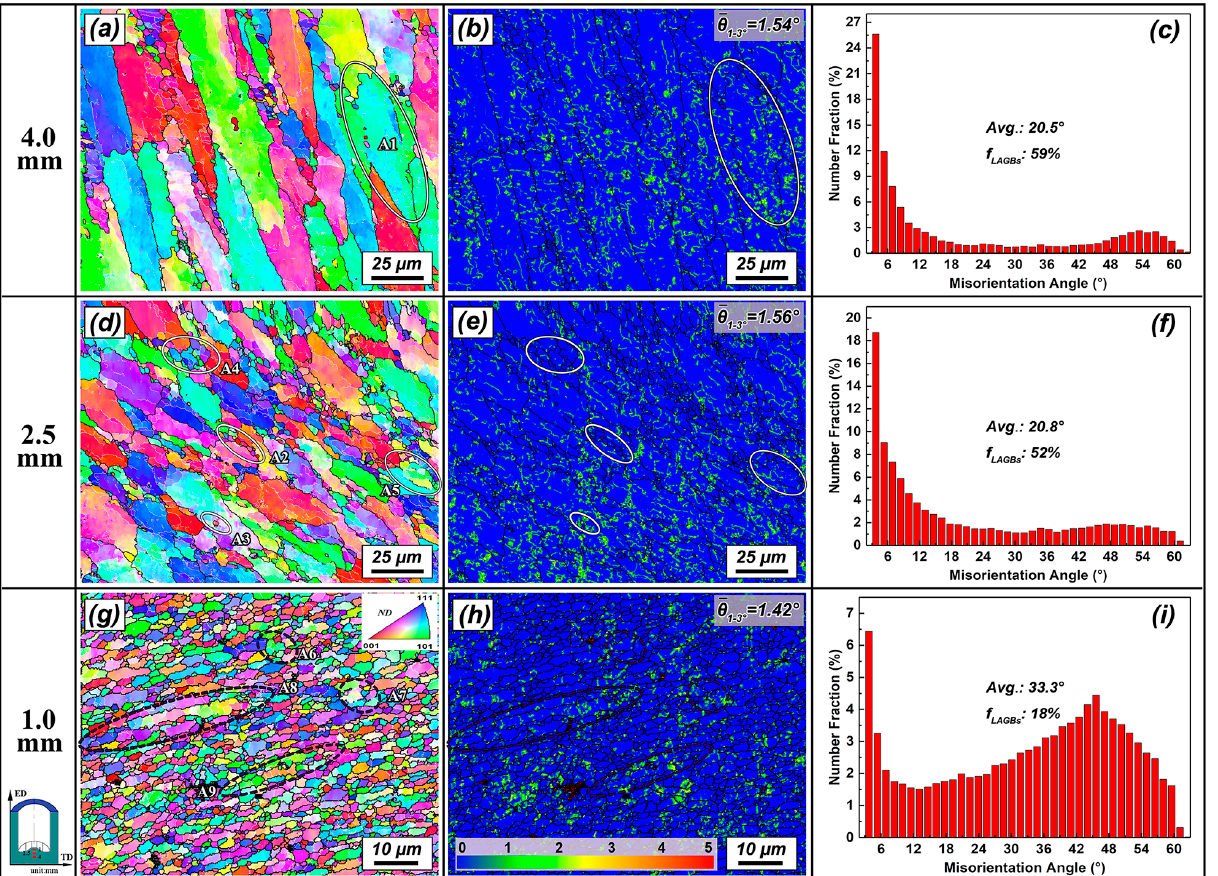
Figure 14. EBSD results showing the microstructure evolution during different stages of RBE (25 N) sample: ( a , d , g ) IPF coloring maps, ( b , e , h ) corresponding KAM distribution maps and ( c , f , i ) misorien- tation angle (MA) distribution